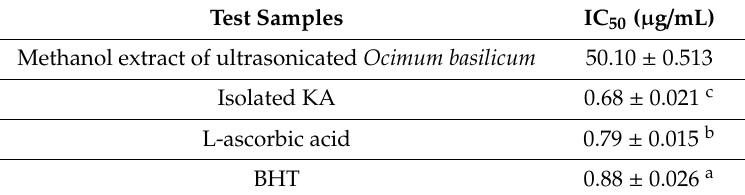
Table 9. Inhibition concentrations of test samples scavenging 50% of the 2,2-diphenyl-1-picryl-hydrazyl- hydrate (DPPH)